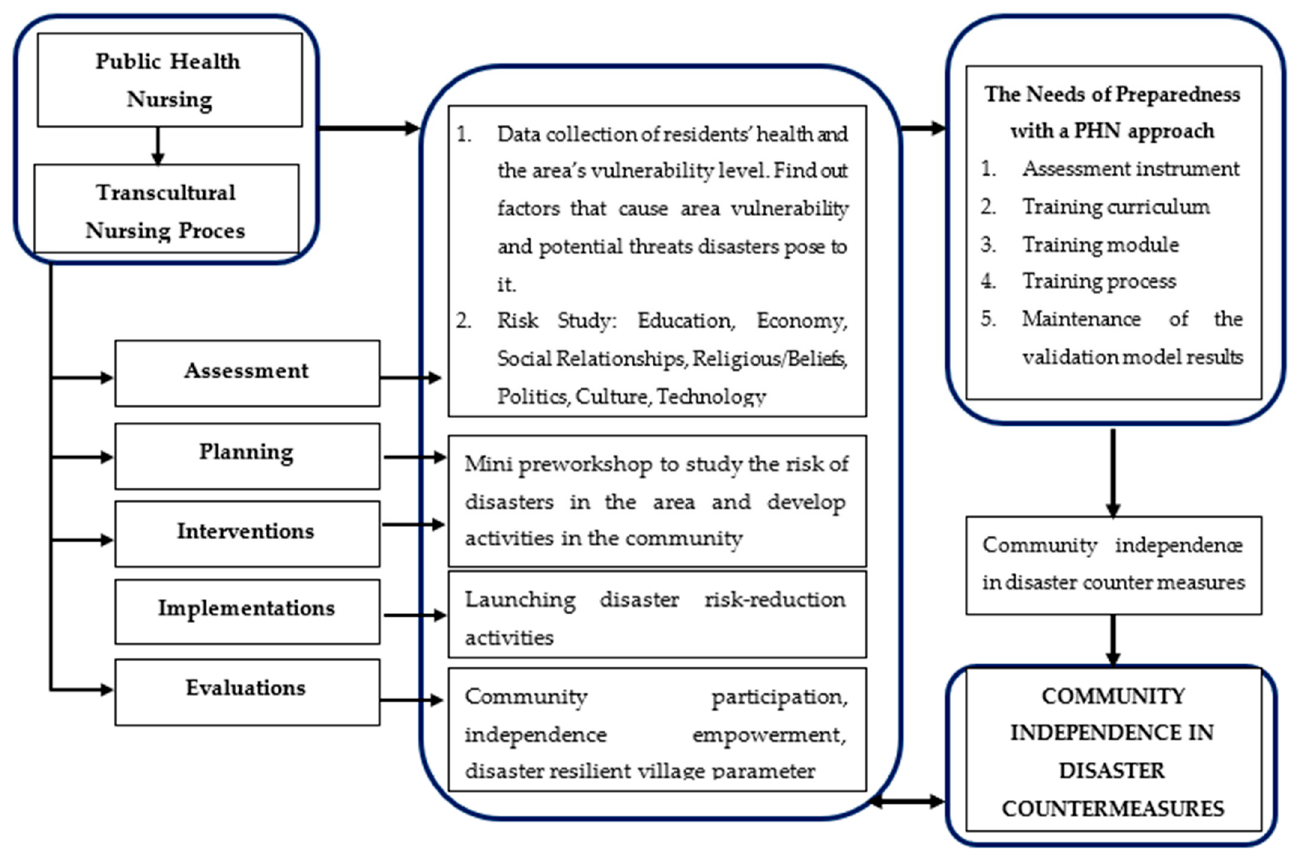
Figure 2. Constructed requirements for the Public Health Care-Based Disaster Preparedness Training integration model.